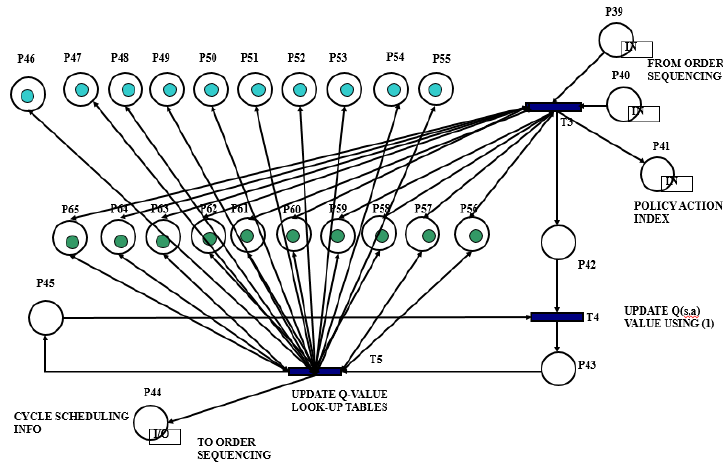
Figure 5. The implemented hierarchical CTPN model of the Perception substitution transition.